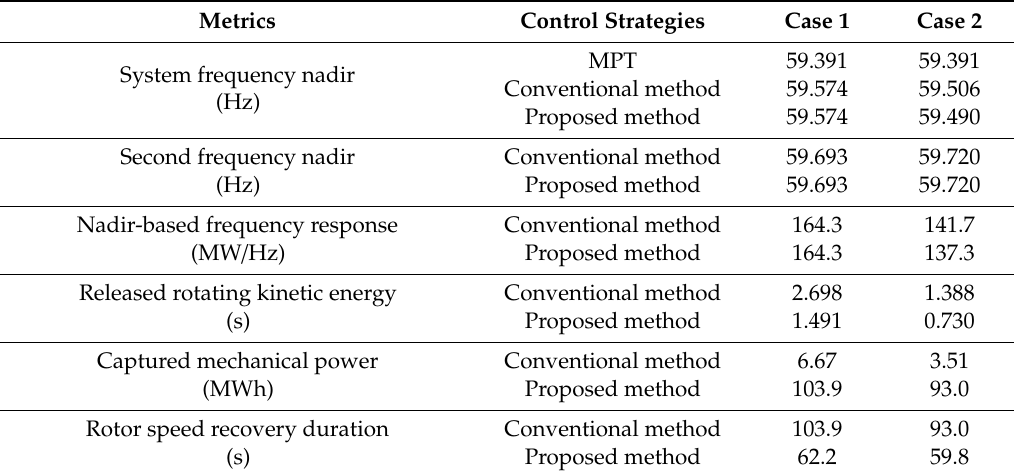
Table 4. Comparison of simulation results for two